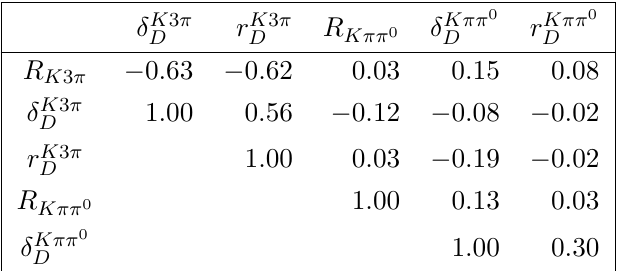
Table 15 . Correlation matrix for the hadronic parameters determined in the global fit.